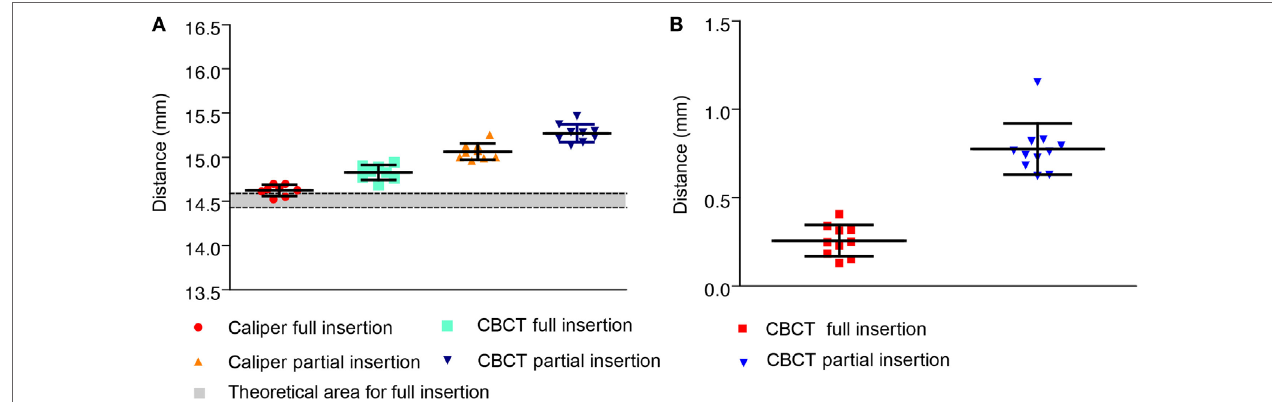
FIgURe 2 | Measurements between the abutment top or implant rim and artificial bone in vitro. Mean ( ± SD) are displayed for fully ( n = 9) and partially ( n = 9) inserted 14 mm bone conduction hearing implants. (A) Distances between implant top and artificial bone surface as measured using a caliper or performed digitally on cone beam CT (CBCT) scans. The approximated theoretical area for full insertion according to the manufacturer specifications is displayed in gray. (B) Distances between the implant rim and artificial bone surface as virtually measured on